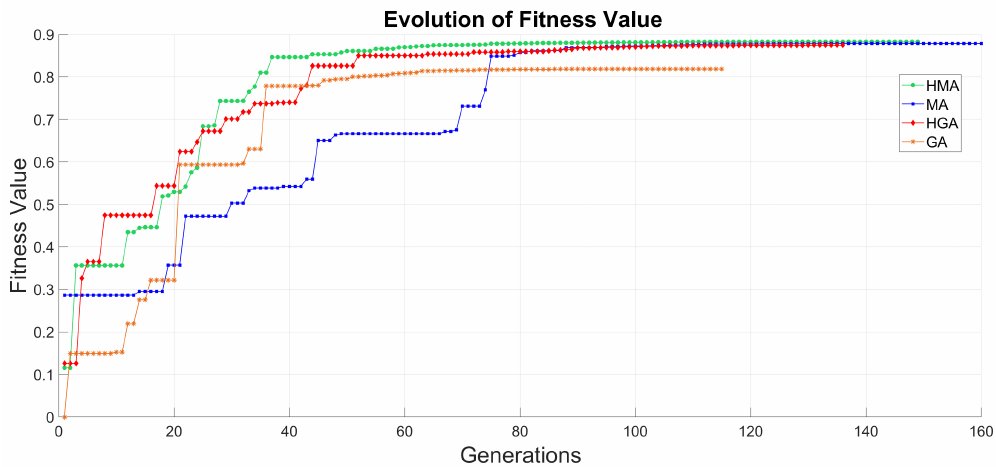
Figure 8. Convergence of the compendium of techniques proposed in this paper for 8